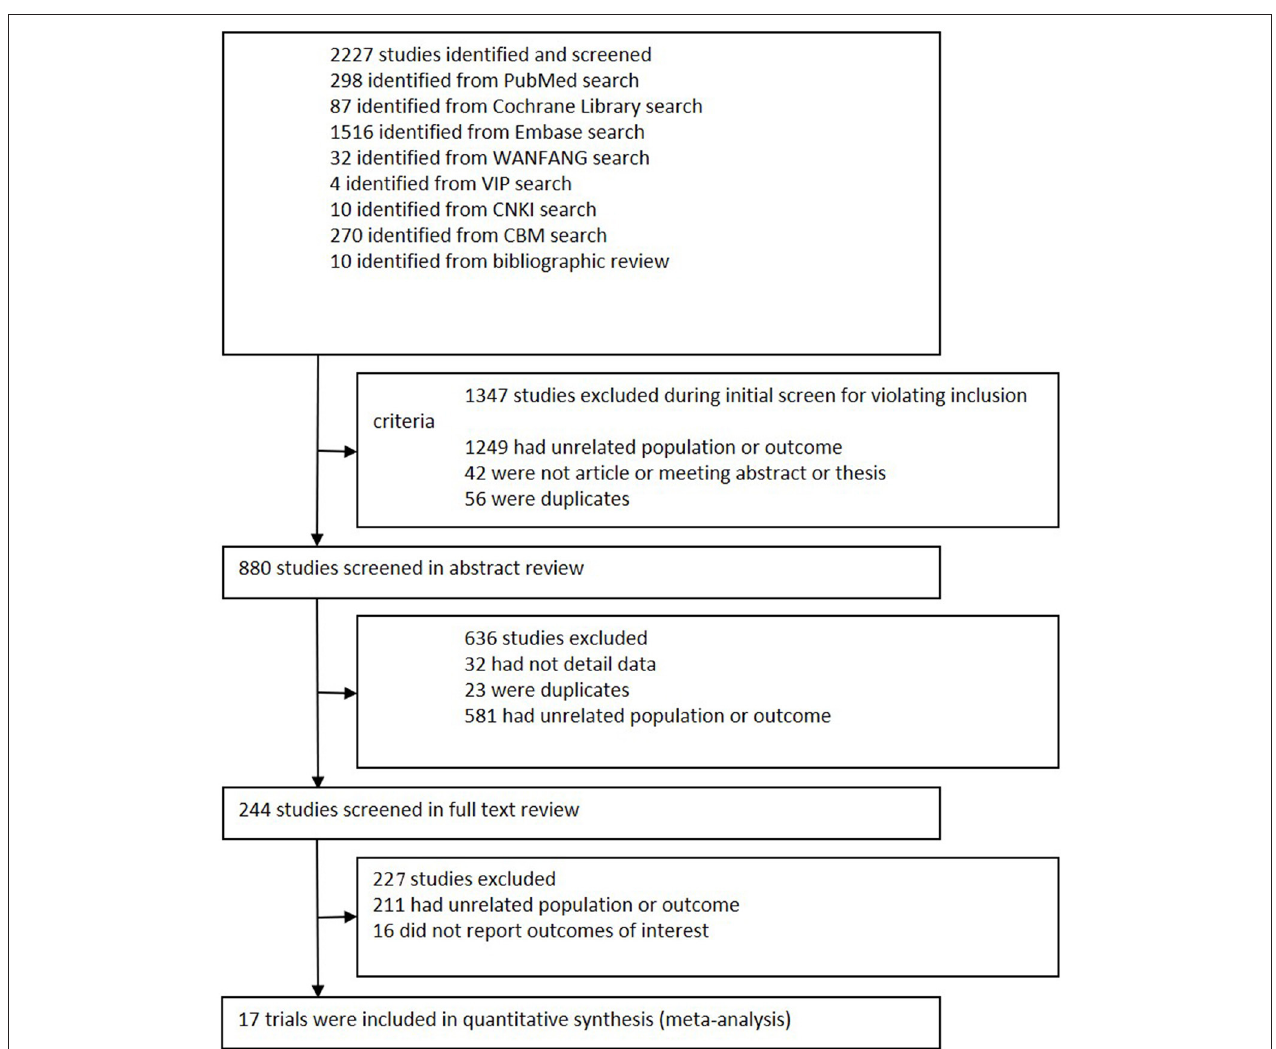
FIGURE 1 | Flowchart of study selection. This flowchart shows the procedure used to select studies according to the inclusion